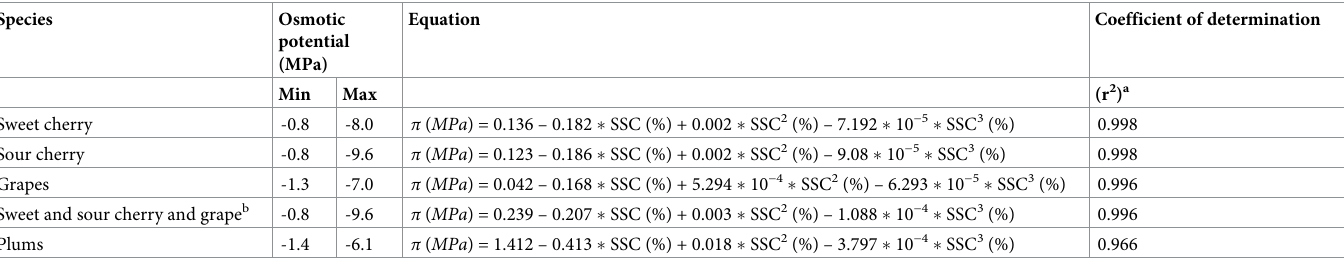
Table 1. Range of osmotic potential, regression equations and the coefficient of determination for the relationships between osmotic potential ( π ) and the concen- tration of soluble solids (SSC) of sweet cherry, sour cherry, grapes and plums.